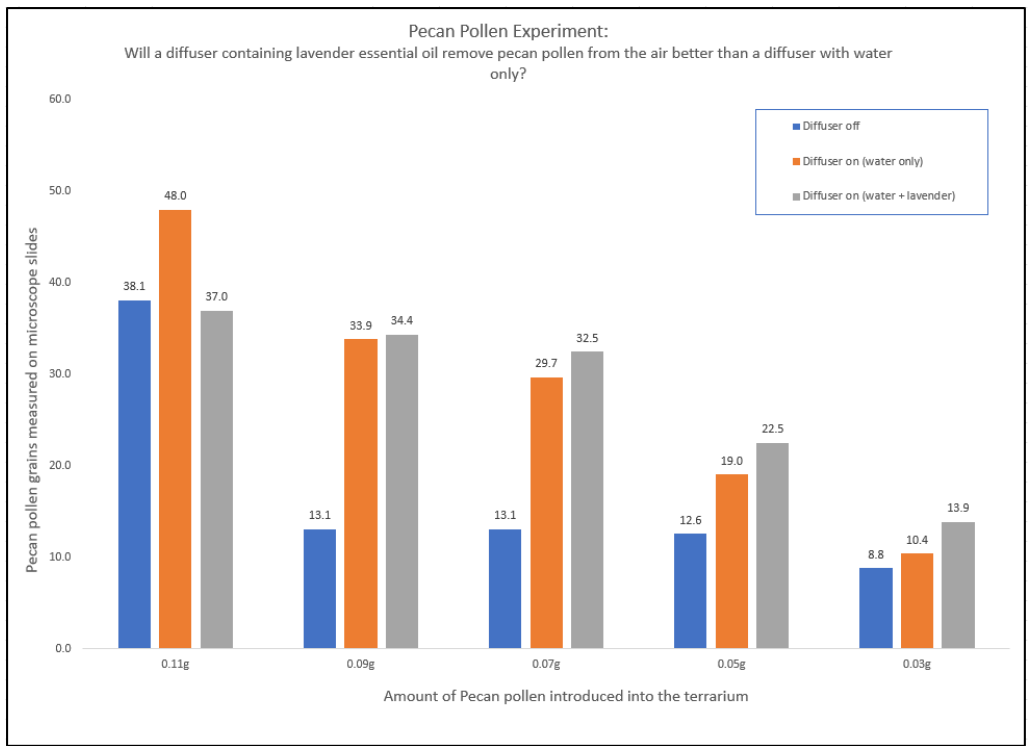
Figure 9. The amount of pecan pollen found on the microscope slides in an environment with dif- fuser off (blue), with diffuser on (water only) (orange), and with a diffuser containing 10 drops of lavender essential oil (grey). Note: Each data point on the graph is the average pollen count of 27 data